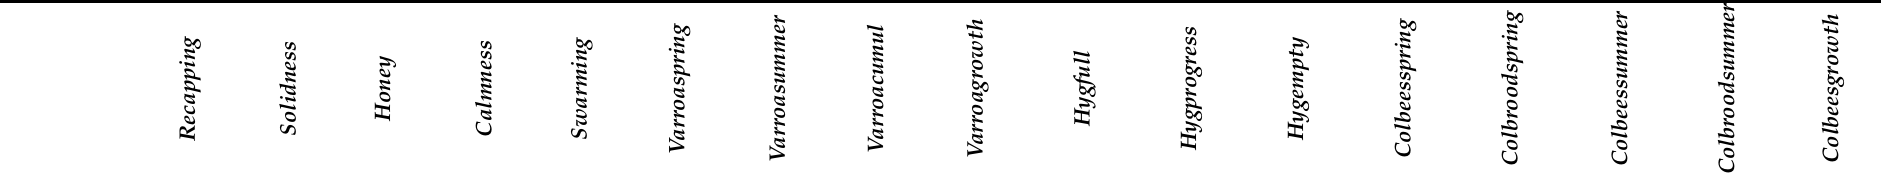
Table 3. Heritabilities (diagonal, grey) for traits and phenotypic correlations (off-diagonal) corrected for apiary effects and associated standard errors (between brackets). For explanation of traits see Table 1. Heritabilities were estimated by the model on worker effects (upper value) and the model of queen effects (lower value). Pearson’s correlation coefficients between phenotypes corrected for apiary effects were estimated by the model on worker effects. Bold correlation coefficients significantly ( p < 0.05) differed from 0; green background corresponds to a positive correlation, an orange background to a negative